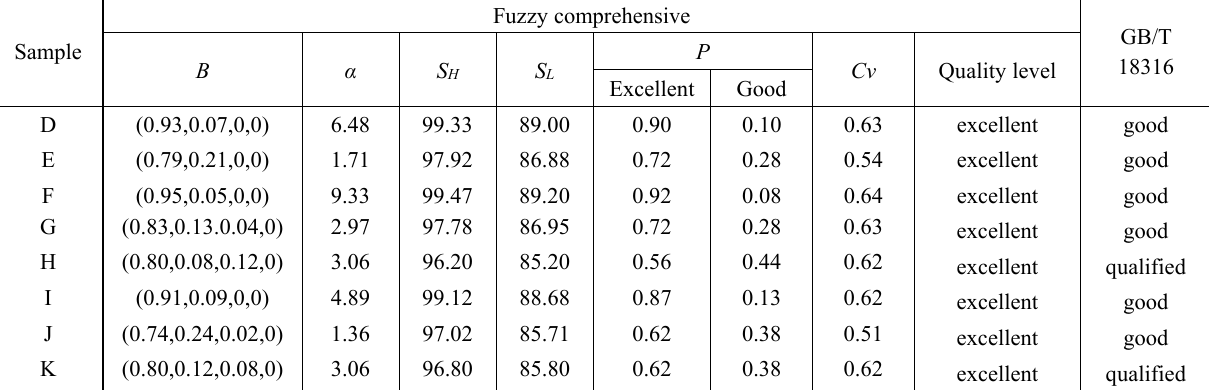
Table.6 Comparative results of fuzzy comprehensive and GB/T